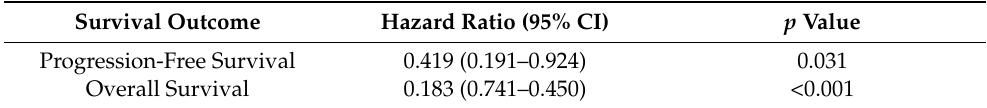
Table 3. Progression-free survival and overall survival by TMB: multivariate analysis with age, stage, and ECOG performance status as